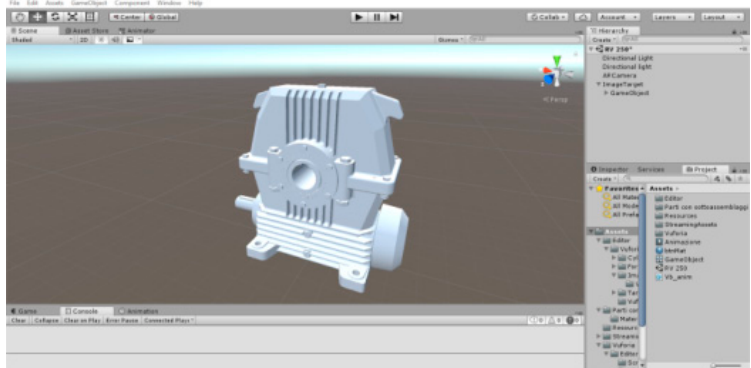
Figure 29. View of the gearbox with Unity (scale 1:1).